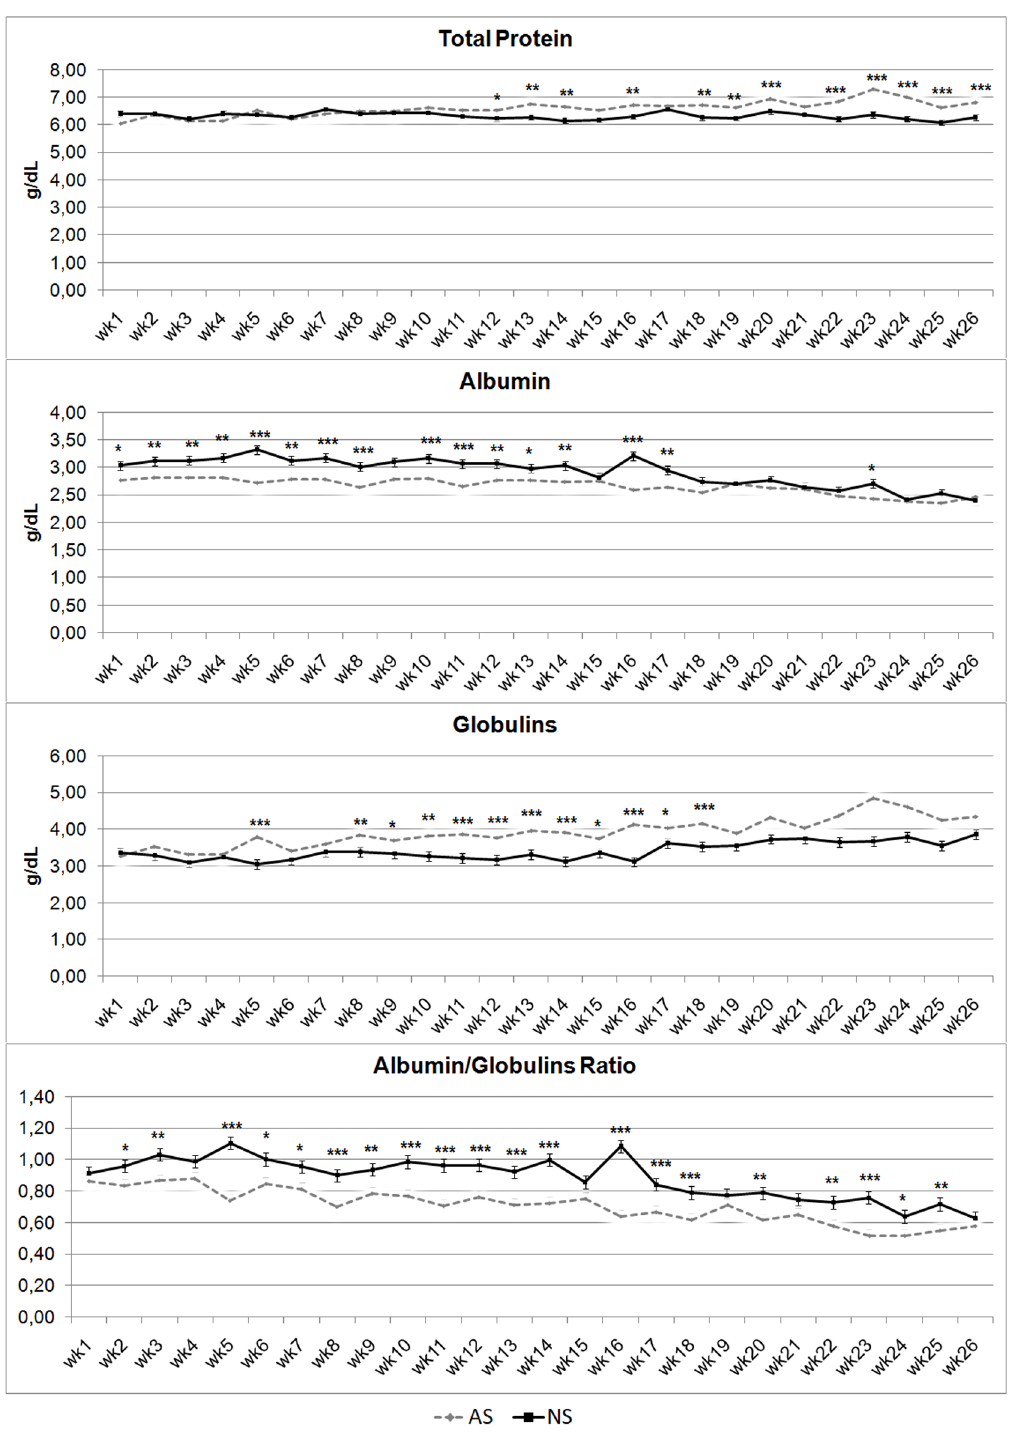
Fig 6. Total protein, albumin, globulins and albumin/globulin ratio levels in artificially-suckled (AS) and naturally- suckled (NS) donkey foals during the first 26 weeks of life. (Values are Least Square Means; bars represents Standard Error of the Mean). Statistical differences between the two groups at the same week were expressed: (cid:3) = P < 0.05; (cid:3)(cid:3) = P < 0.01; (cid:3)(cid:3)(cid:3) = P < 0.001.